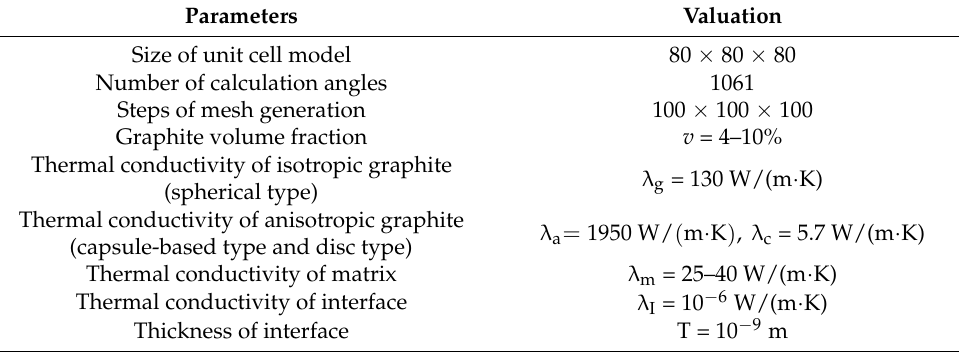
Table 2. Parameters of numerical